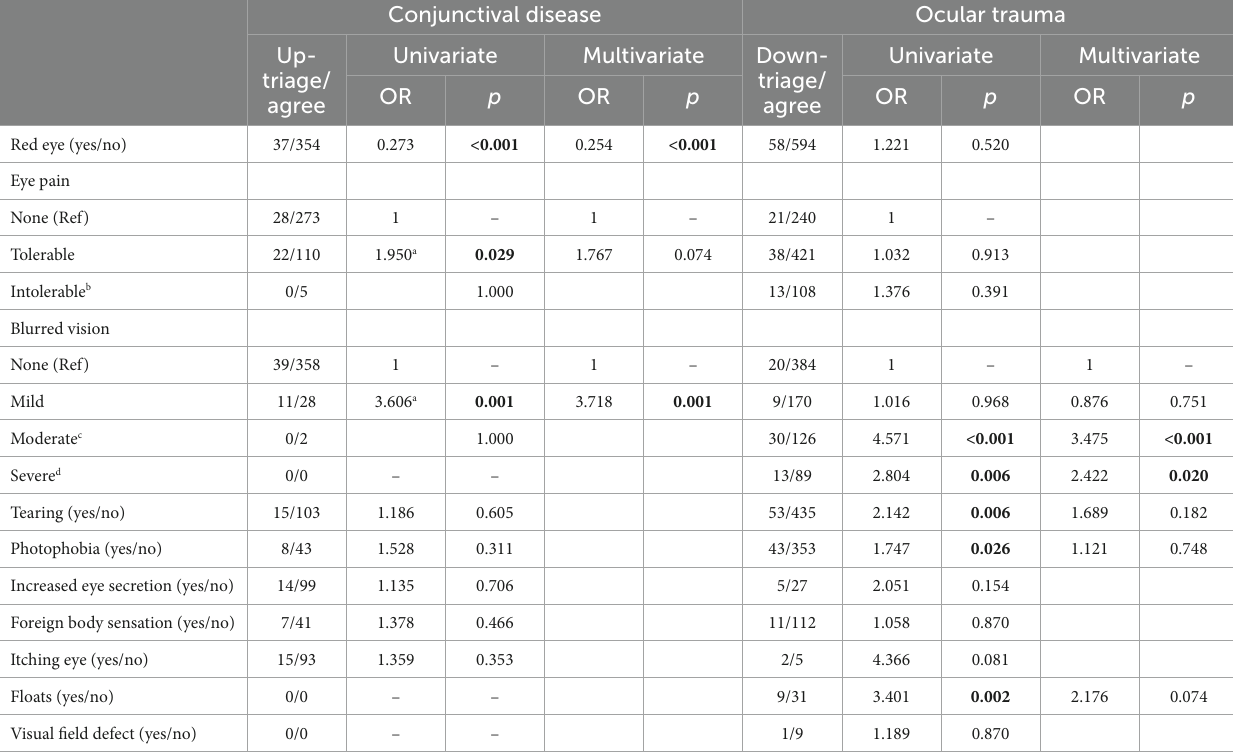
TABLE 5 Binary logistic regression analysis to assess risk factors for conjunctival disease up-triage and ocular trauma down-triage.